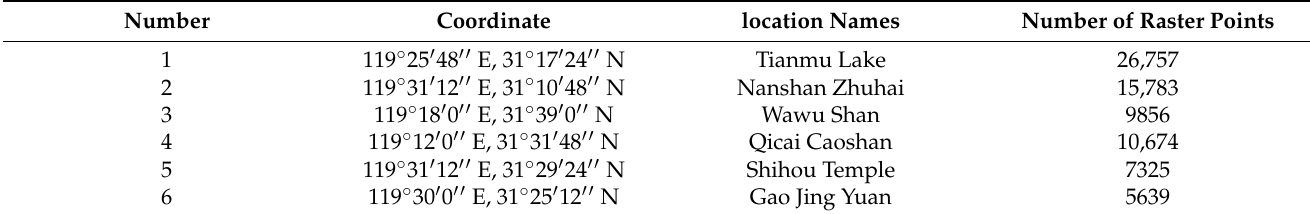
Table 5. Coordinate identification of key resource points.